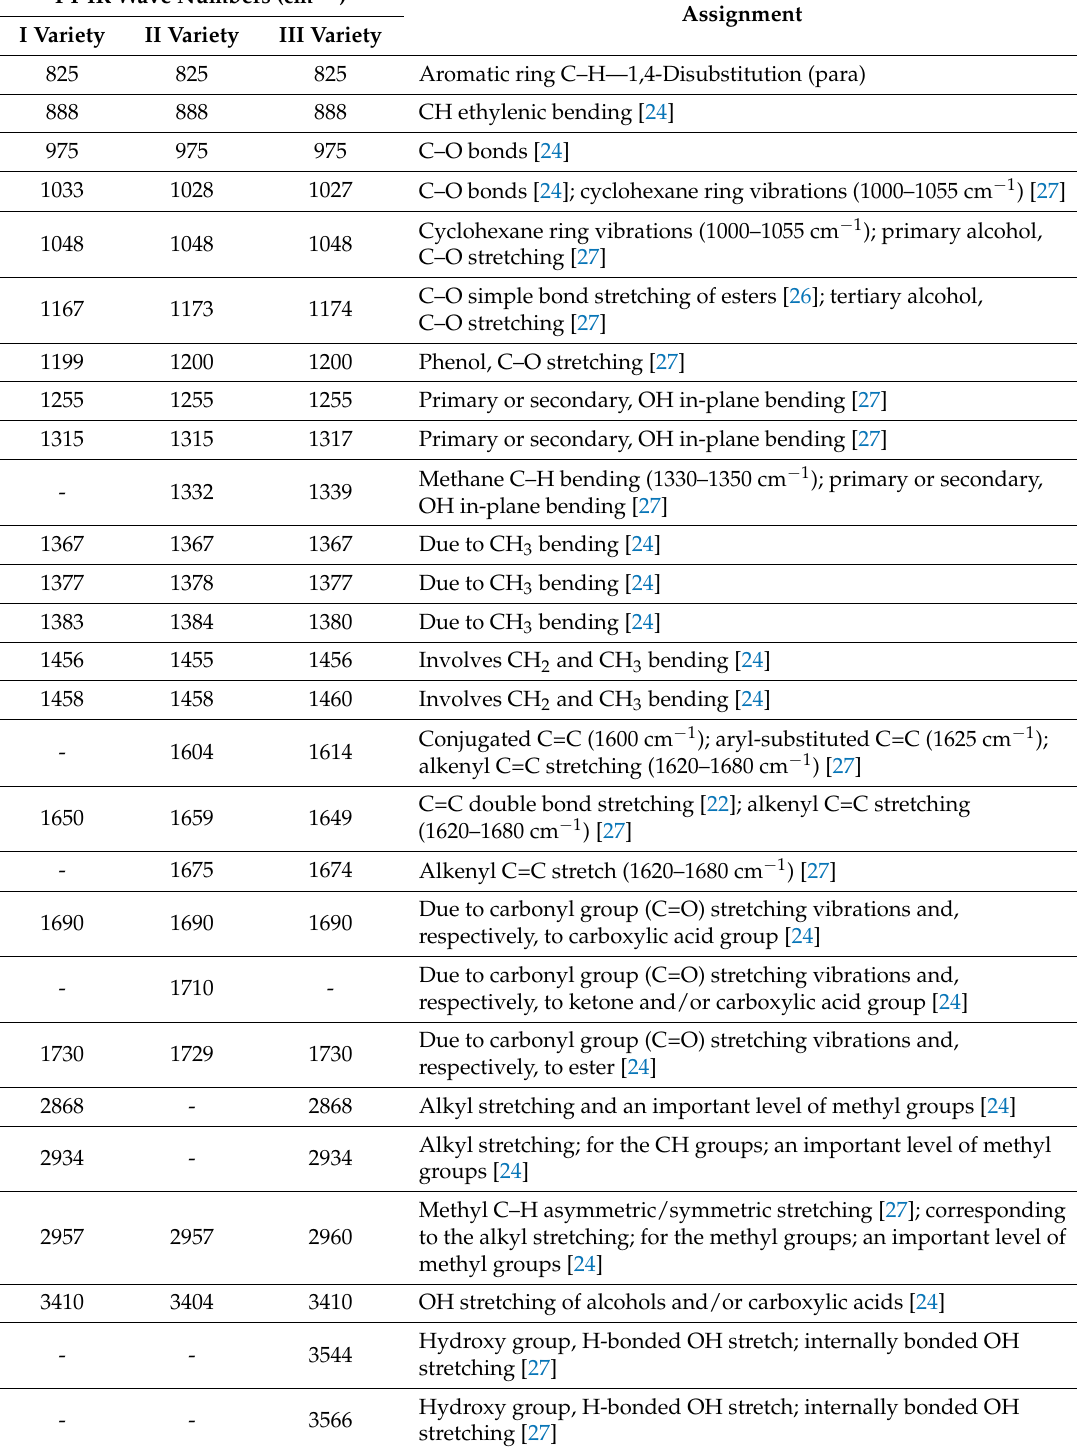
Table 2. FT-IR bands